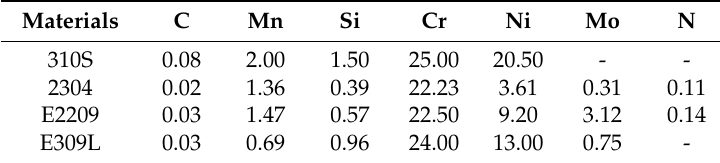
Table 1. Chemical composition (% weight) of the base and filler metals.